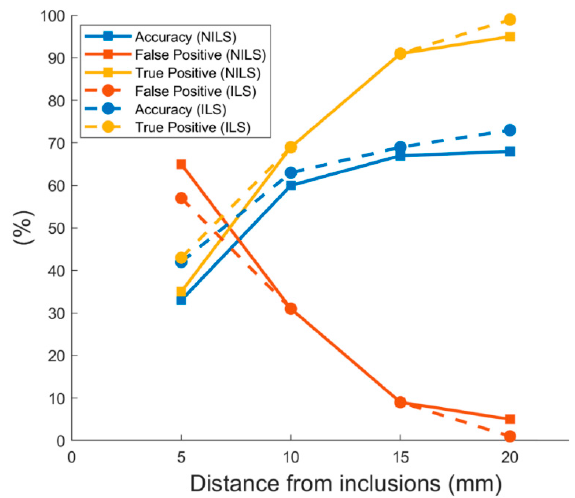
Figure 6. Tolerance of recognized inclusions: each point (dots for ILS and squares for NILS) represents the mean accuracy (blue line), mean false positive (red line), and mean true positive (yellow line) responses evaluated through a classification based on the admitted center ‐ to ‐ center distance between perceived inclusions and the real ones.